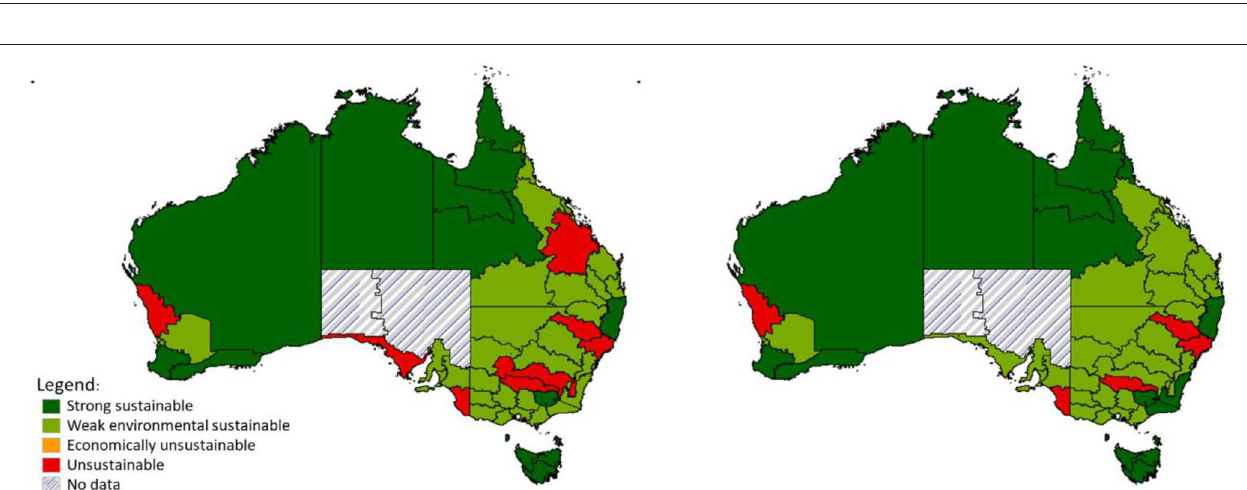
FIGURE 6 | Map of sustainability paradigm of the irrigation practice using groundwater.